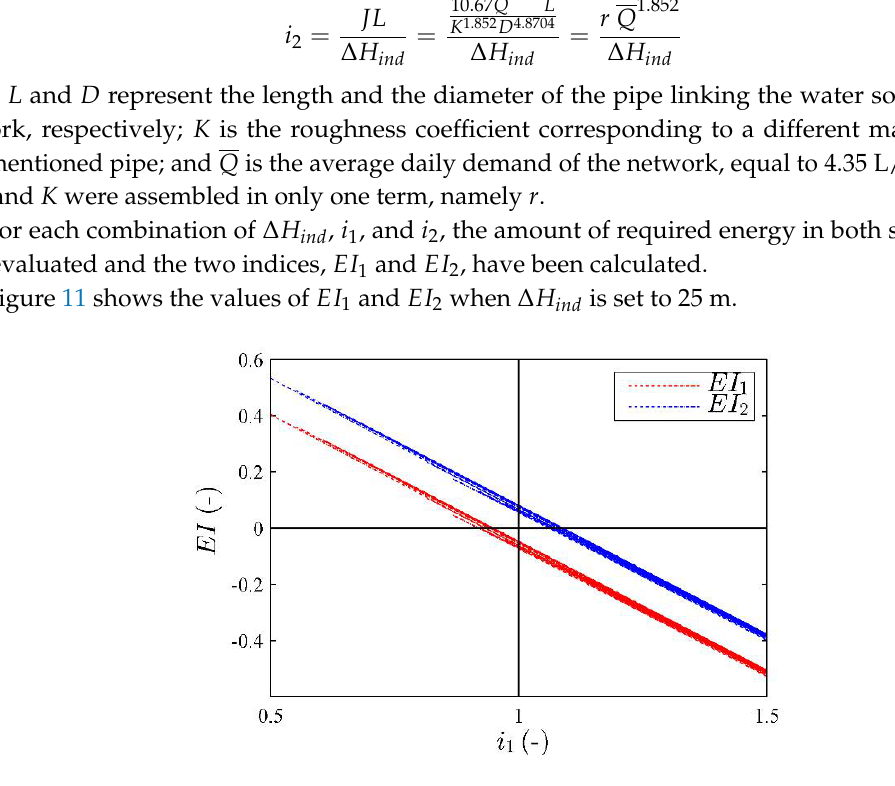
Figure 11. Trend of efficiency indices for ∆ H ind = 25 m with i 2 equal to 25%, 50%, and 75%, respectively.